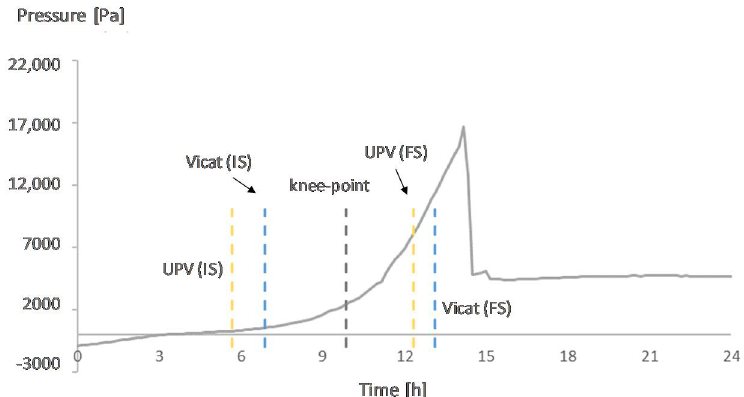
Figure 9. Capillary pressure, setting times, and transition point of SAP2. With IS referring to initial setting and FS referring to final setting.